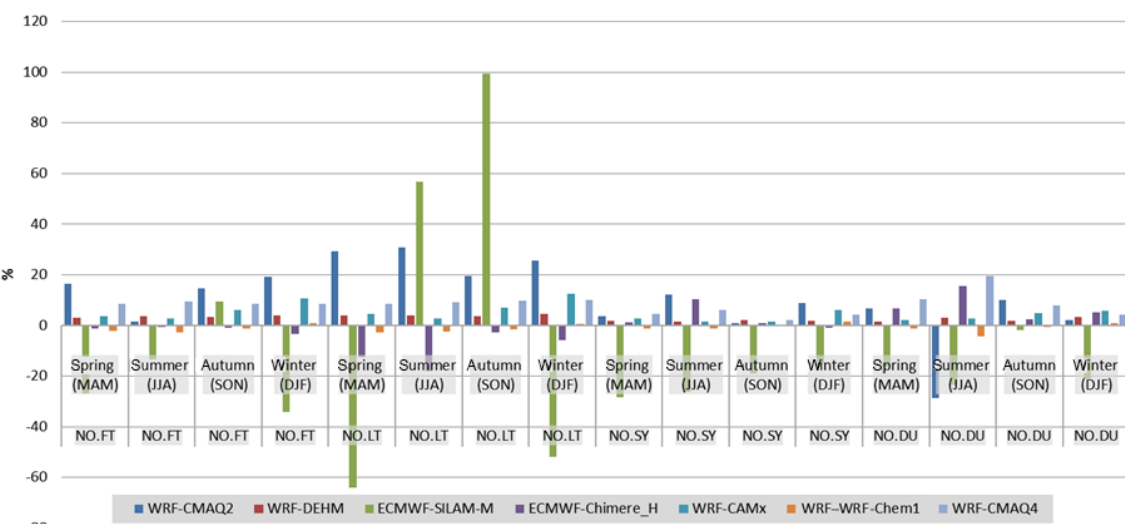
Figure 13. RMSE variation between the s20% scenario (anthropogenic emission and boundary condition reduced by 20%) and the base case for anthropogenic NO (aNO) in